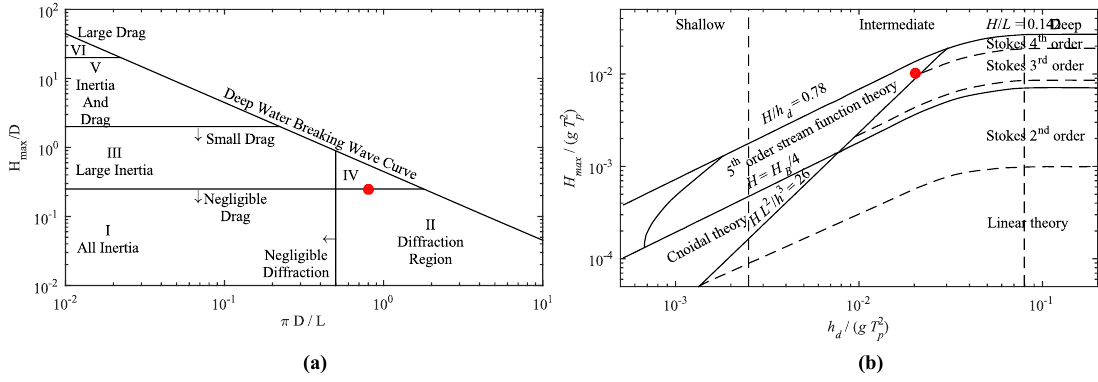
Figure 1. ( a ) Plot of the case investigated later in this paper (red marker) as a function of wave height H , characteristic diameter D and wavelength L . The defined wave force regimes are in accordance with the boundaries defined in [1,24]; ( b ) Plot of the investigated case (red marker) as a function of wave height H , wave period T and water depth h d and with the indication of needed wave